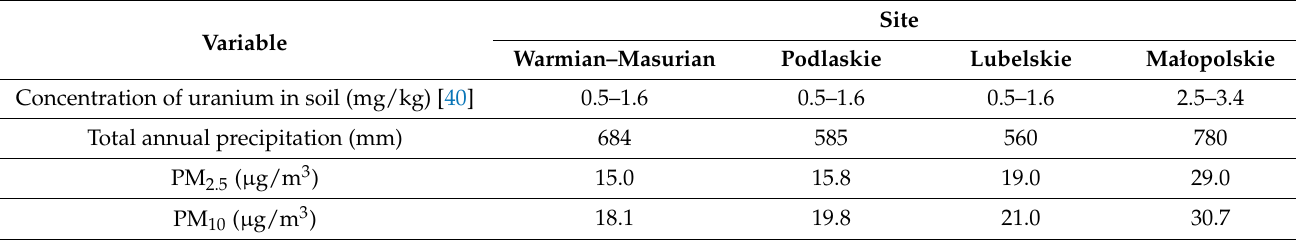
Table 1. 210 Po activity concentration (mBq/L) in fruit wine samples derived from different locations Table 2. Characteristics of production location of studied fruit in Poland.